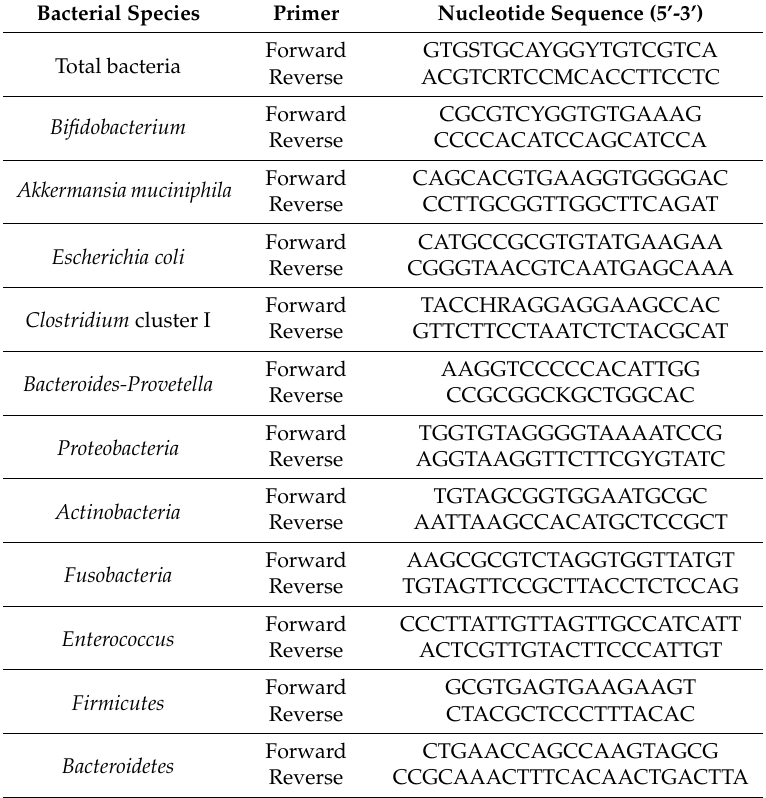
Table 1. Primers used for the quantification of gut specific